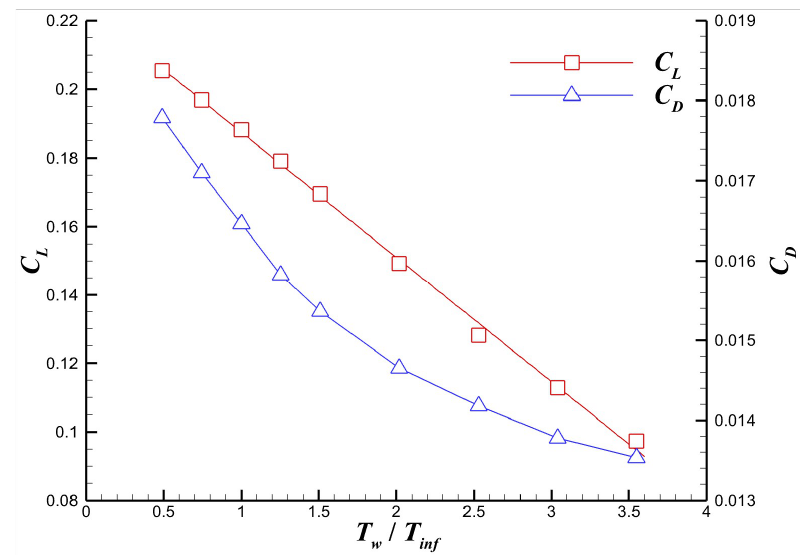
Figure 6. Effect of wall-temperature gradient on on C L and C D of CHN-T1. Figure 7 provides the temperature gradient’s influence on different components. As each component accounts for a different proportion of the aerodynamic coefficients of the